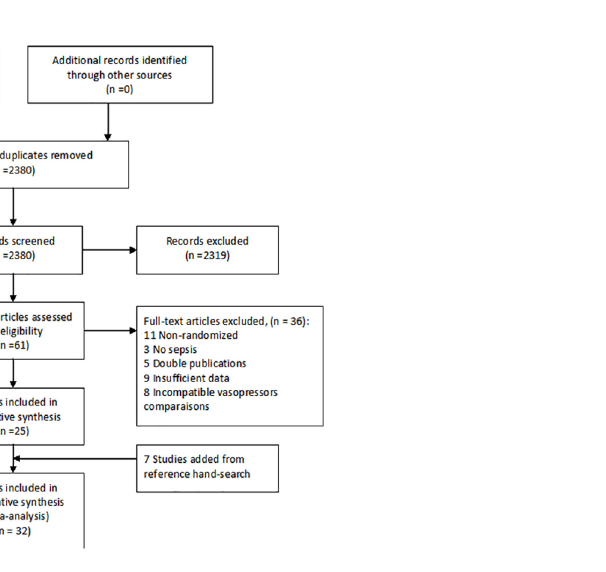
Fig 1. Study flow